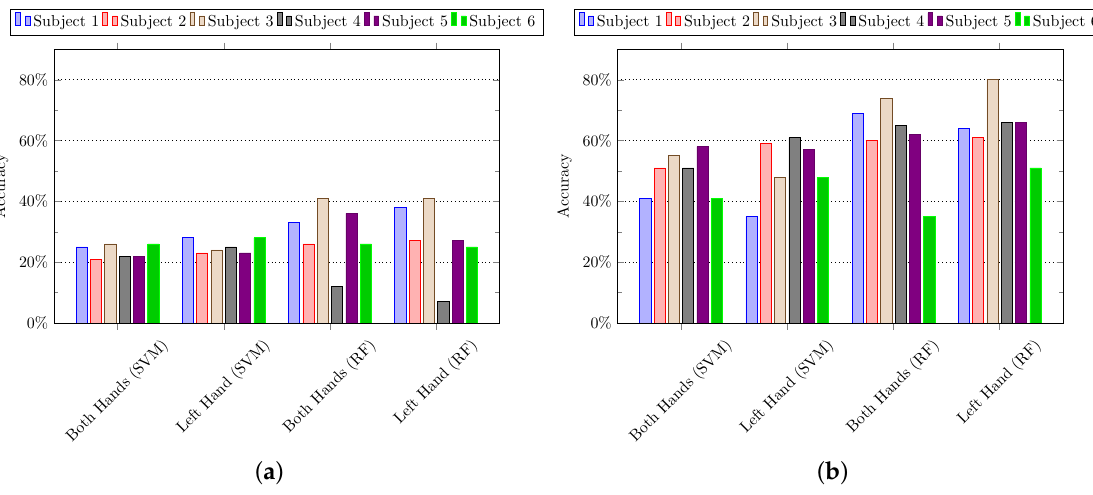
Figure 8. The composite activity recognition using features derived from the subspace pooling technique. The features are classified using Support Vector Machine (SVM) and Random Forest (RF). ( a ) Leave-one-out cross-validation: subspace pooling using singular value decomposition (SVD), and ( b ) leave-one-out cross-validation: subspace pooling using principal component analysis